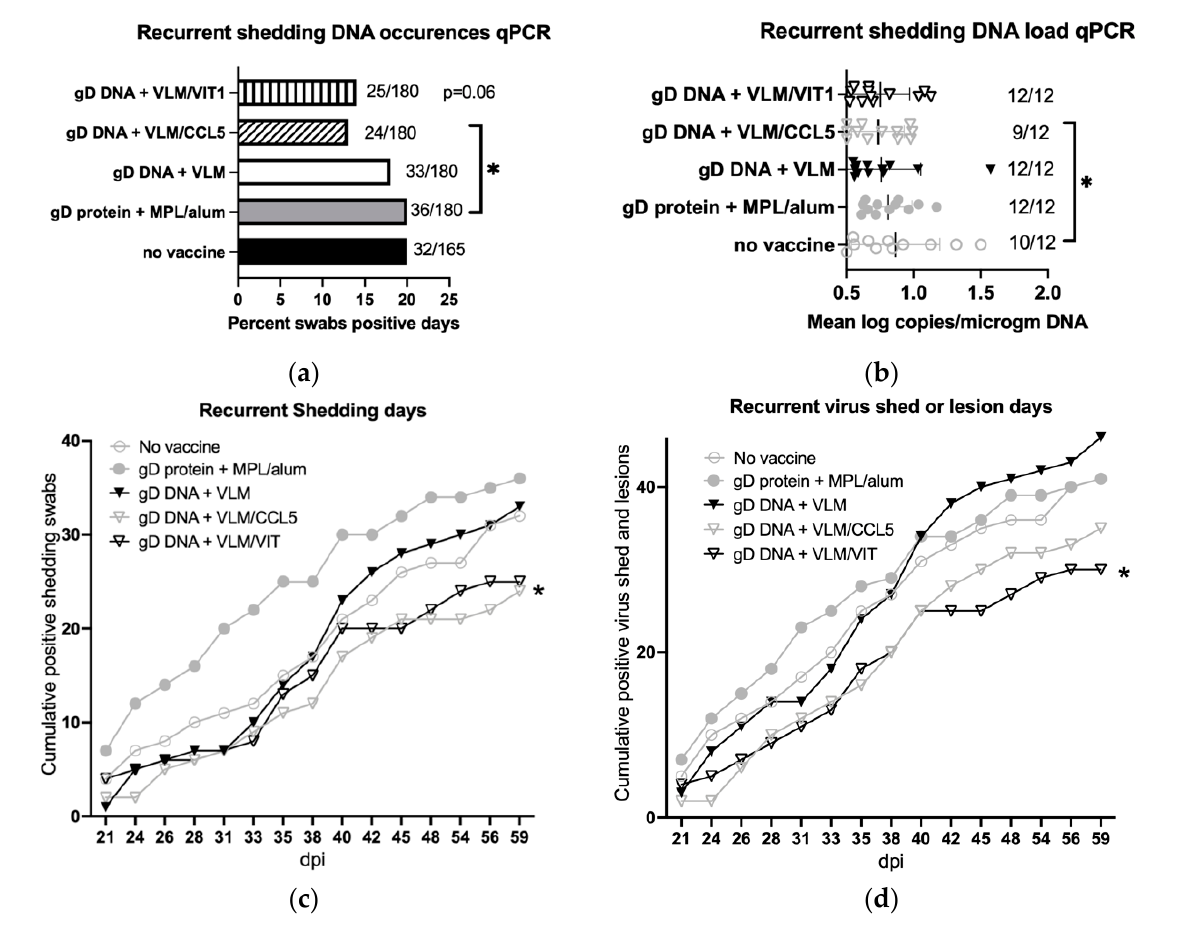
Figure 7. Immunisation with VLM vaccines with VIT show reductions in recurrent virus shedding in vaginal swabs or lesions from day 21–63. ( a ) Comparison of recurrent shedding occurrence as detected by quantitative DNA PCR above detection cut-off, one tailed chi square. ( b ) Recurrent shedding loads were compared between immunisations and no vaccine after HSV-2 challenge, as analysed in pairwise comparisons by Wilcoxon test, P < 0.05 (*). ( c ) Positive vaginal shedding swabs assayed by quantitative DNA PCR were recorded daily and cumulative events plotted. ( d ) Combined recurrent disease lesions and virus shedding events recorded cumulatively daily, P < 0.05 (*) two tailed chi square at end of study compared to no vaccine. Table 1. Vaccine efficacy protecting from acute or recurrent HSV-2 disease or